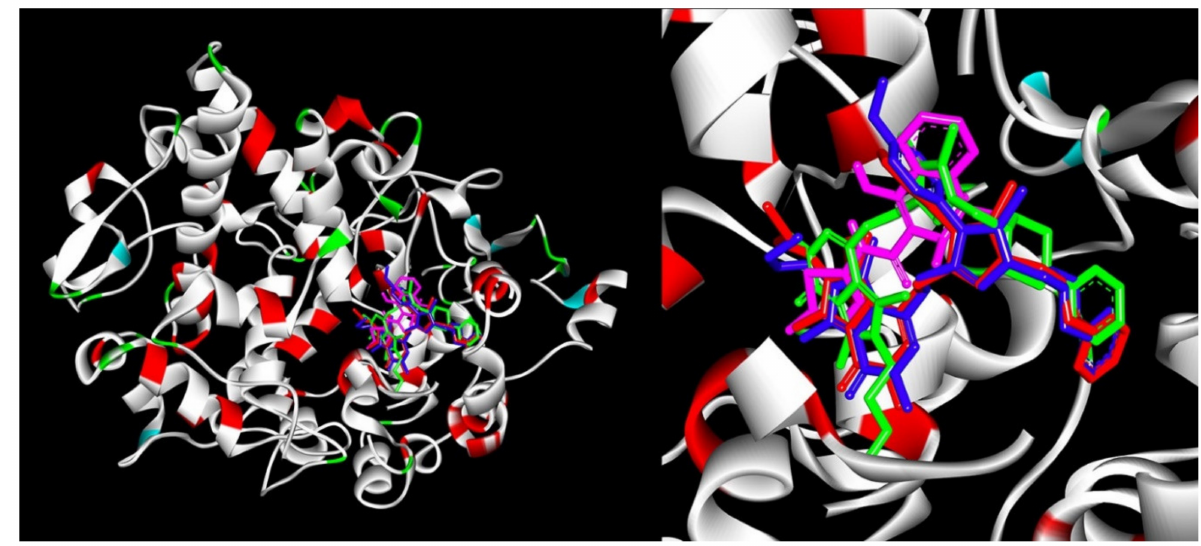
Figure 4. Docking poses of 4a (green), 4b (red), 4c (blue) and Meloxicam (pink) inside